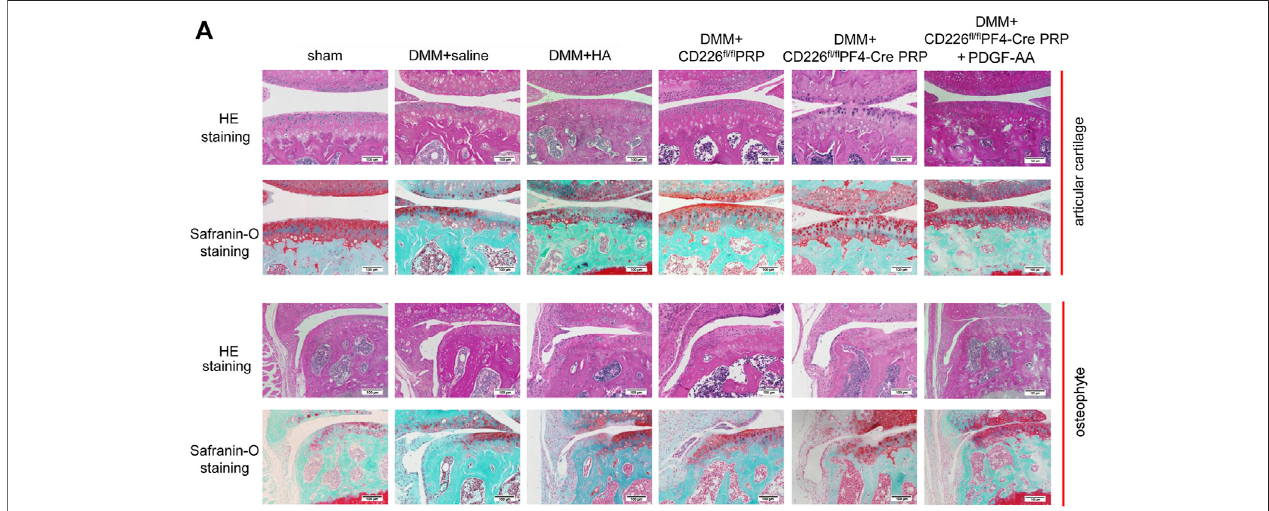
FIGURE5| DeletionofplateletCD226diminishedtheprotectiveeffectsofPRPonarticularcartilageofDMMmice,andPDGFrestoredit. (A) HEandsafraninO-fast green staining of sagittal sections of the medial compartment of the tibia. Scale bar (cid:1) 100 µm.